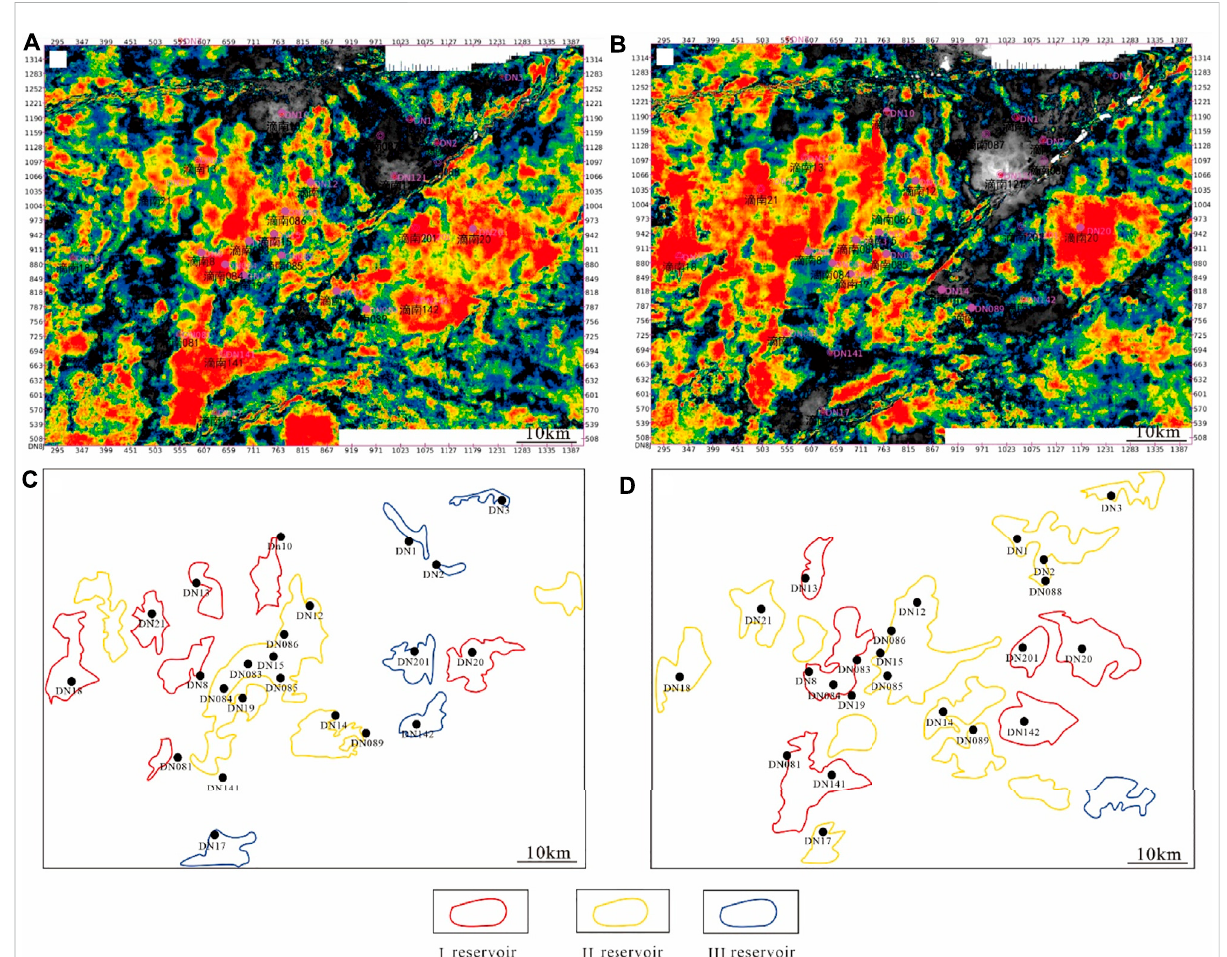
FIGURE 10 Inversion plans of the PermianUpper Wuerhe Formation of the Dinan 15 well block and plane prediction diagrams of Type I, II and III reservoirs. (A) Inversion plan of Section I, the Permian Upper Wuerhe Formation of the Dinan 15 well block; (B) Inversion plan of Section II, the Permian Upper Wuerhe Formation of the Dinan 15 well block; (C) Plane distribution diagram of Types I, II and III reservoirs of Section I, the Permian Upper Wuerhe Formation of the Dinan 15 well block; (D) Plane distribution diagram of Types I, II and III reservoirs of Section II, the Permian Upper Wuerhe Formation of the Dinan 15 well